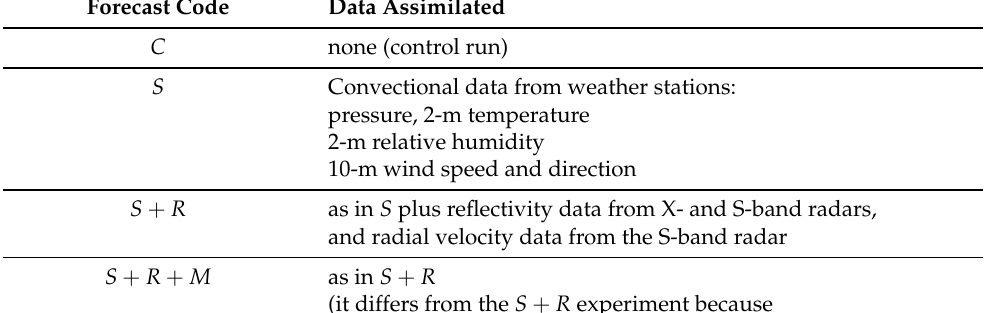
Table 2. Codes assigned to name the forecasts and descriptions of the data used in each assimi- lated forecast.